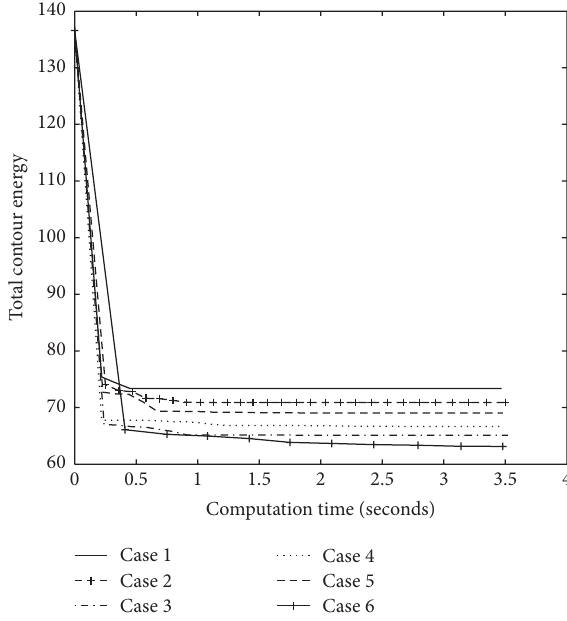
Figure 8: Contour energy versus computation time plot for “mul- tipopulation PSO” method with six different cases of inertia in case of “MRI” image.